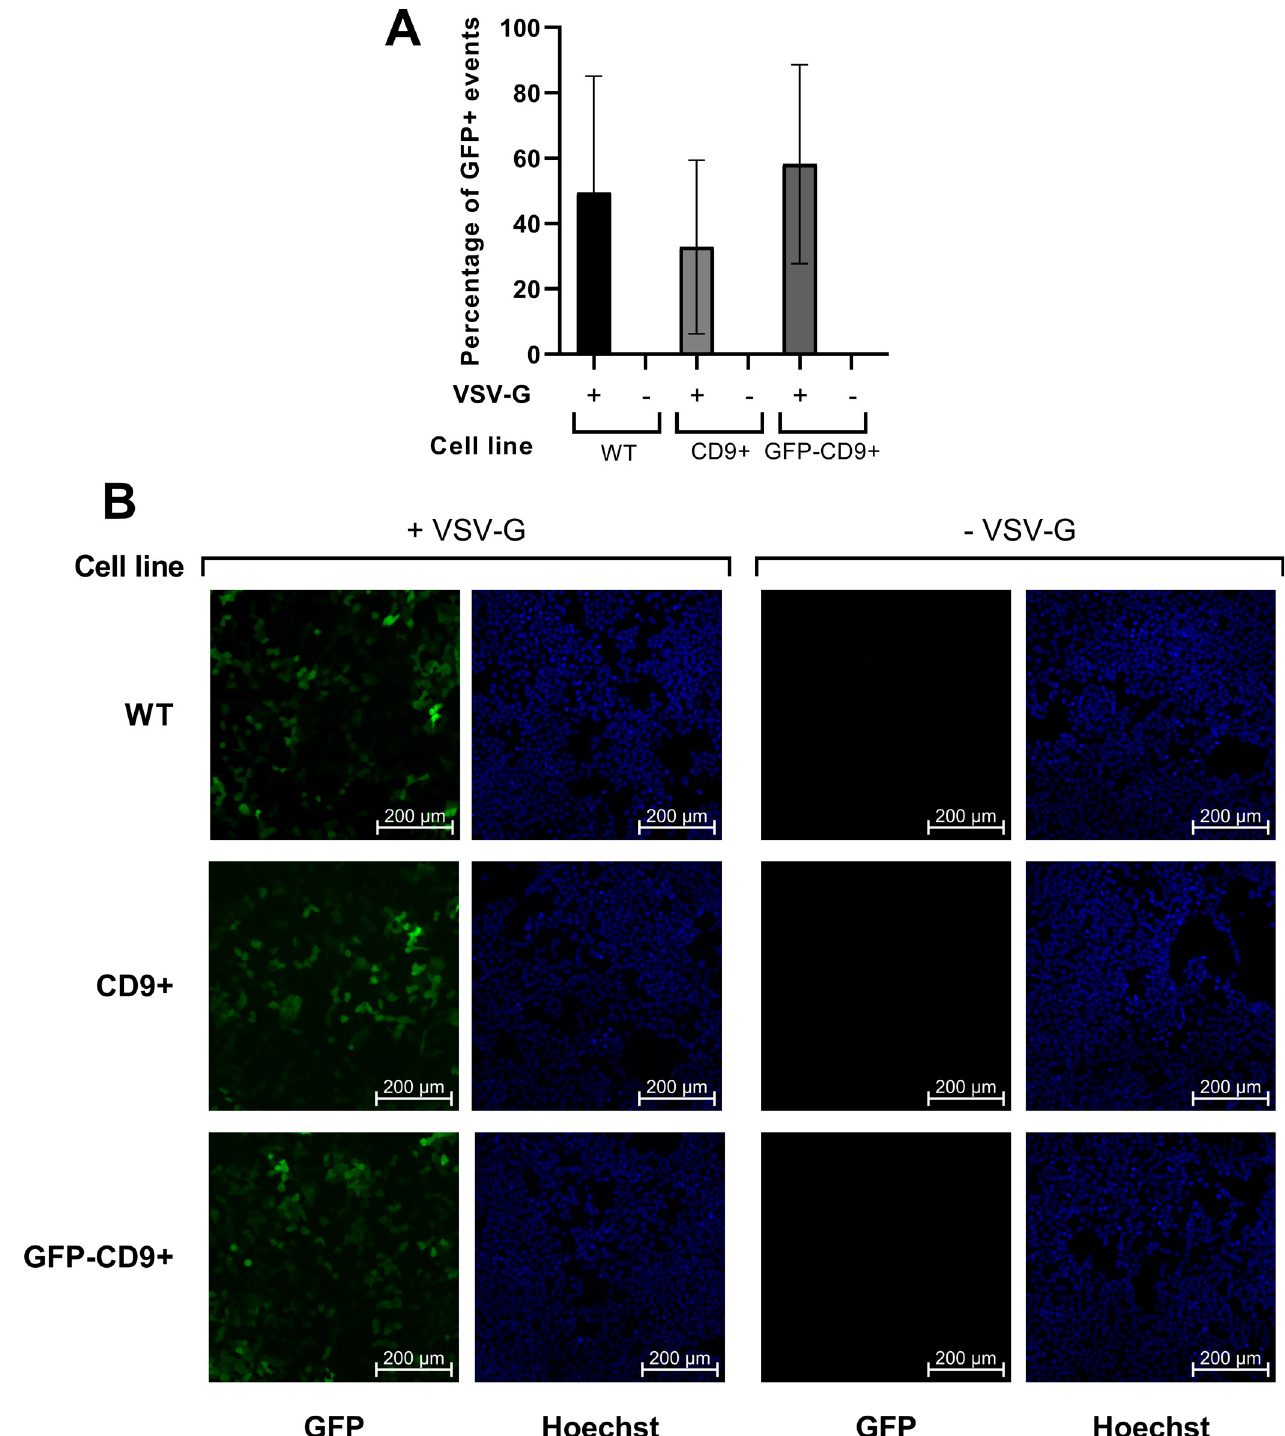
Fig 3. CD9 has no effect on LV transduction. (A) Transduction efficiency of LVs produced in different cell lines ± VSV-G, measured as percentage of GFP + cells detected by flow cytometry 48h after transduction (n = 5). All data are represented as mean ± s.d. (B) Microscopy images were taken 72h after transduction. GFP signal is shown in green, Hoechst 33342 in blue. No GFP-positive cell was detected in absence of VSV-G (n = 3).